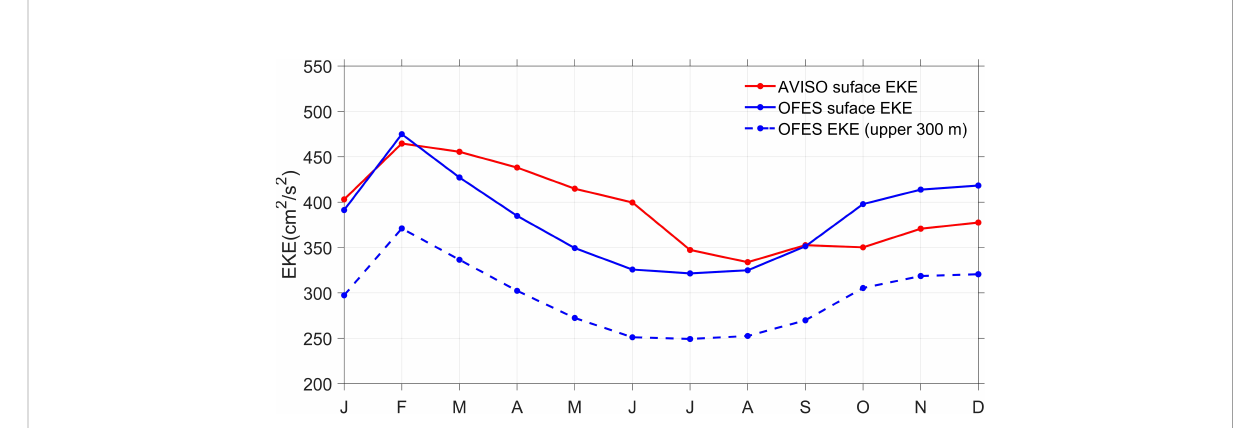
FIGURE 3 Monthly EKE time series in the EAC region (148°E-160°E, 30°S-45°S) calculated from AVISO during January 1993-December 2019 and from OFES during July 1999-October 2009. Red solid line and blue solid line represent surface EKE from AVISO and OFES, blue dash line represents averaged EKE over the upper 300 m layer from